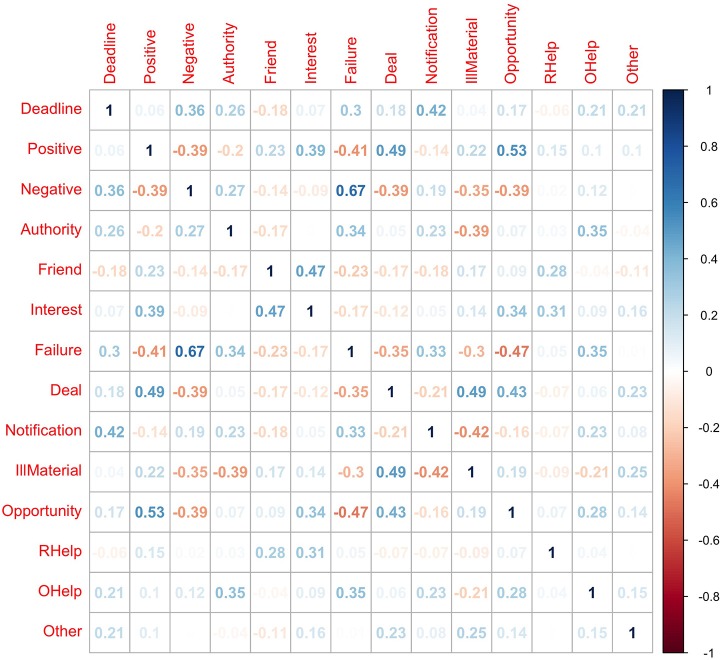
Visualization of pair-wise, polychoric correlation of occurrence between 14 strategies.